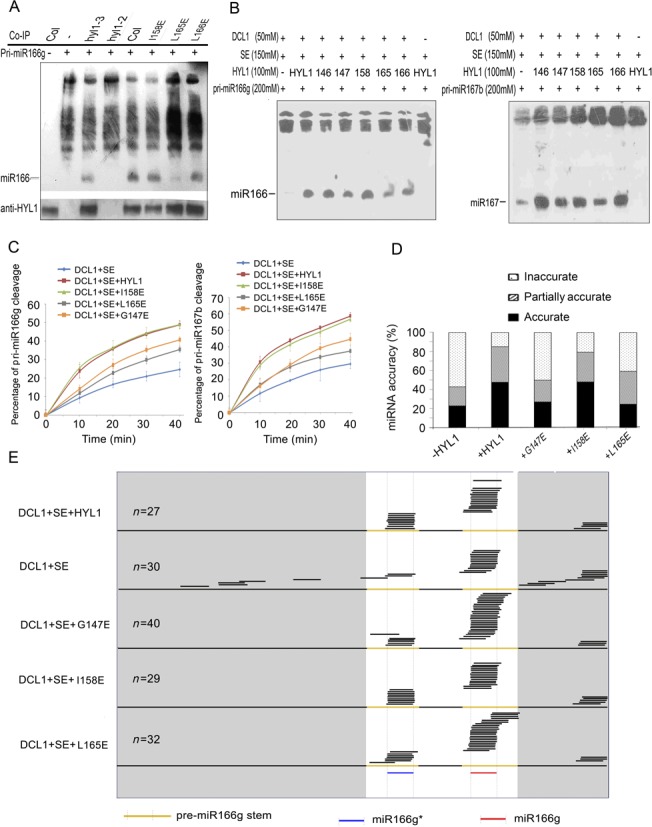
In vitro processing of pri-miRNA to mature miRNA. (A) Pri-miR166g processing using the immunoprecipitates of the transgenic plants expressing HYL1 mutants. (B) In vitro pri-miRNA processing using pri-miR166g and pri-miR167b as the substrates. 146, HYL1T146E; 147, HYL1G147E; 158, HYL1I158E; 165, HYL1L165E; 166, HYL1L166E. (C) Pri-miR166g and pri-miR167b processing rates of HYL1 mutants. (D) Effects of HYL1 mutants on pri-miR166g processing. −HYL1, absence of HYL1 in the processing complex; +HYL1, HYL1 presence; +G147E, HYL1G147E presence; +I158E, HYL1I158E presence; +L165E, HYL1L165E presence. (E) Distribution of the sequenced small RNAs generated from in vitro processing reactions of different HYL1 mutants.